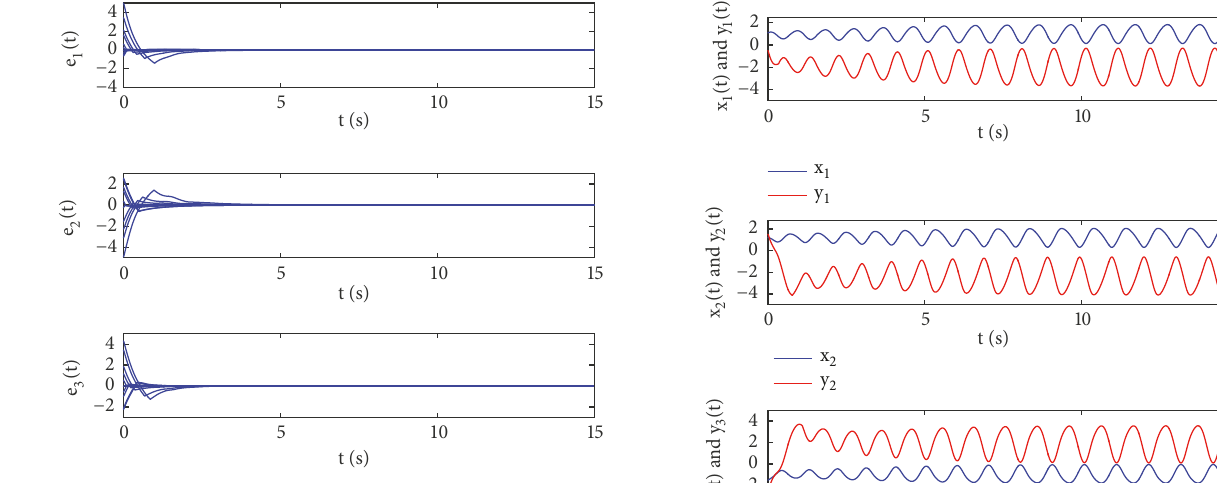
Figure 6: Select 10 random initial conditions and state trajectories of the synchronization errors 𝑒 1 (𝑡) , 𝑒 2 (𝑡) , and 𝑒 3 (𝑡) with 𝜉 = 1 .